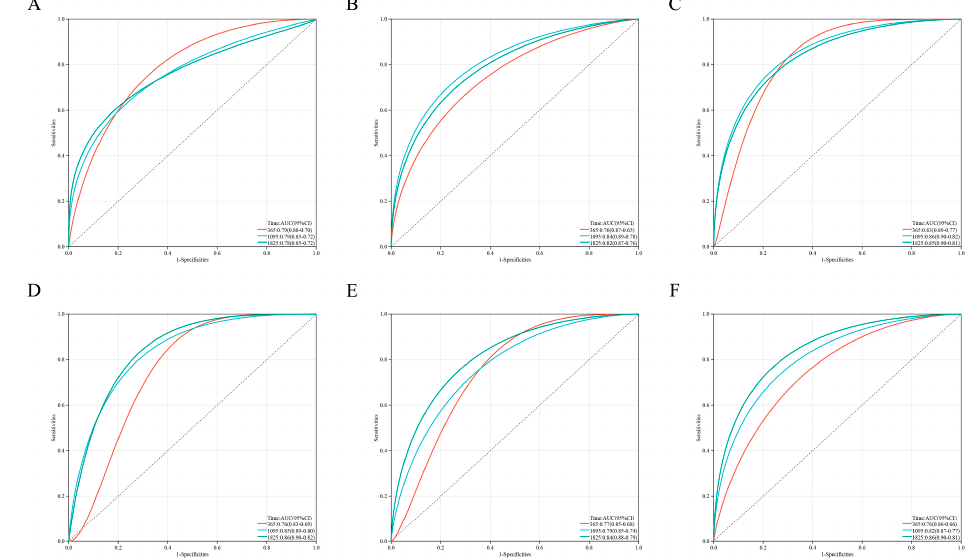
Figure A2. ( A – F ) is Kaplan–Meier analysis of ACHE, CROT, GDPD5, HSD17B3, PIK3R1, PRKACB in order.